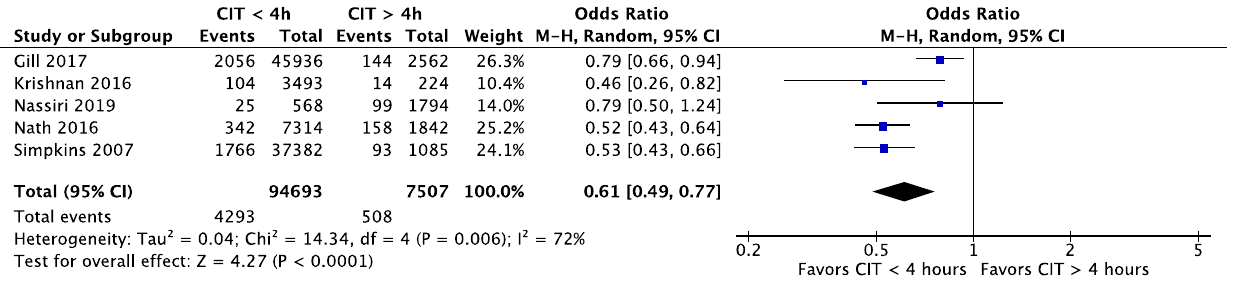
Figure 2. The incidence of DGF for CIT shorter and longer than 4 h. CIT: cold ischaemia time; DGF: delayed graft function.